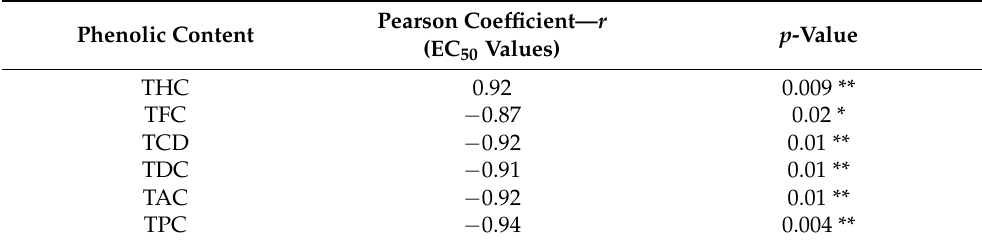
Table 4. Pearson correlation analysis between the antioxidant capacity (EC 50 values) and the phenolic content of Hibiscus roseus leaves and flowers extracts. Phenolic Content (EC 50